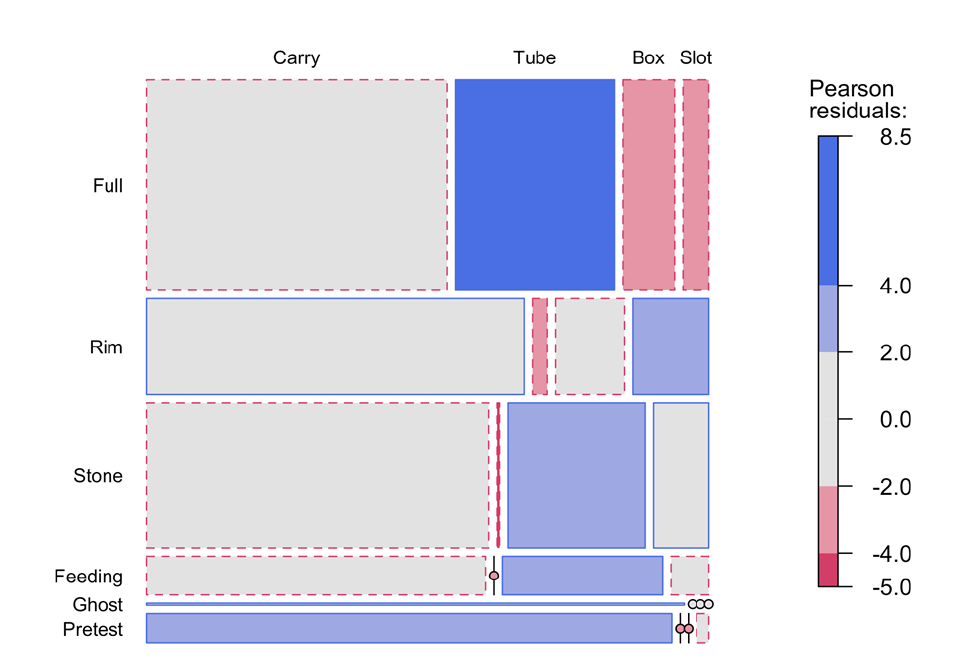
Mosaic Plot of Stone-Related Behaviors in Different Experimental